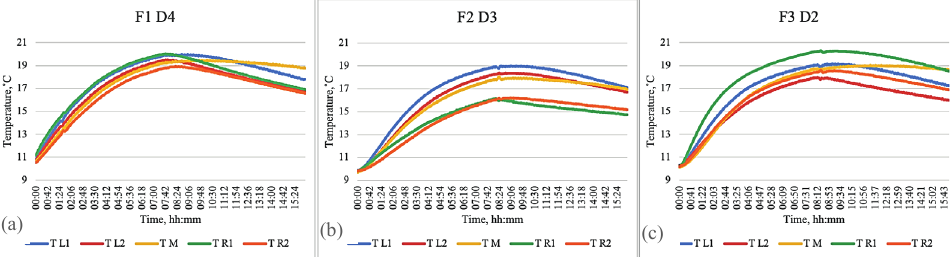
Fig. 9. Temperatures in PCM different layers (L1, L2, M, R1, R2) in Setups F1 D4 (a), F2 D3 (b) and F3 D2 (c).